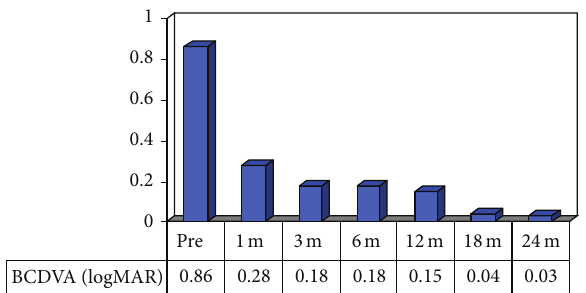
Figure 3: Postoperative rebubbling rate.